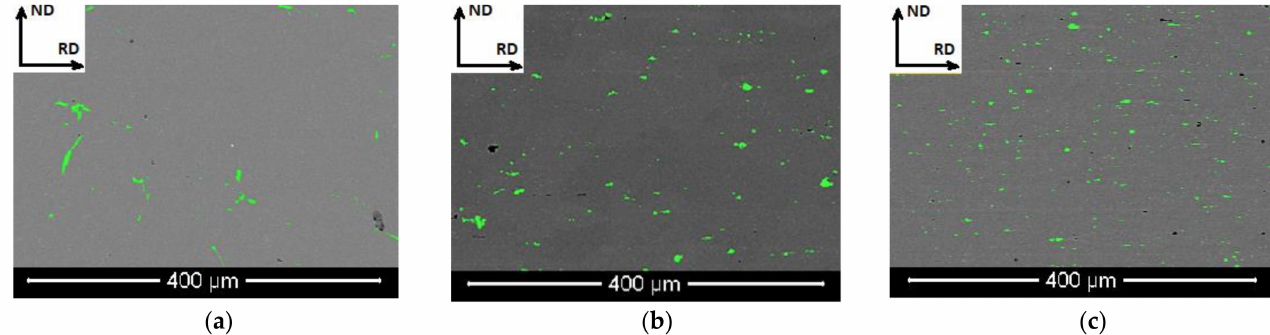
Figure 10. Micrographs of samples etched to reveal 5182 alloy phases: ( a ) 32.2% deformation, ( b ) 67.13% deformation, ( c ) 83.53%